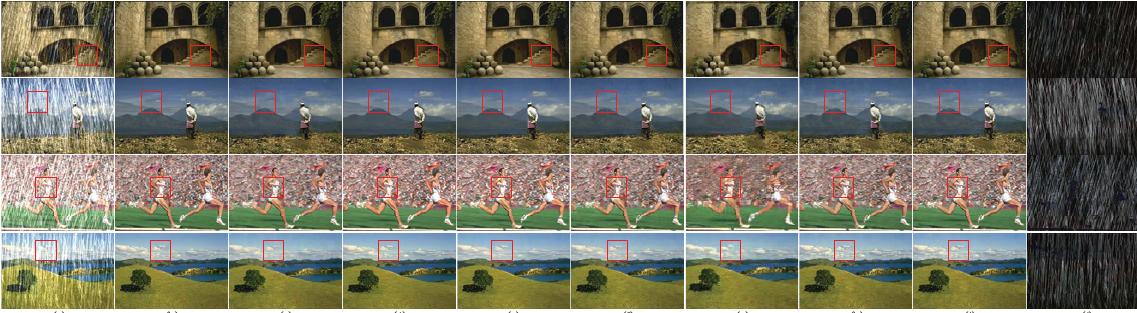
Figure 7. The de-raining results of the synthetic dataset Rain200H by comparing SOTA methods. ( a ) Rainy image. ( b ) Ground-truth. ( c – g ) Results from RESCAN [12], MPRNet [16], PCNet [17], ReMAEN [32], MSPFN [13]. ( h ) Deraining result from CR stage of our method. ( i ) Deraining result from RR stage of our method. ( j ) Rain streak by our method. Please zoom in to see